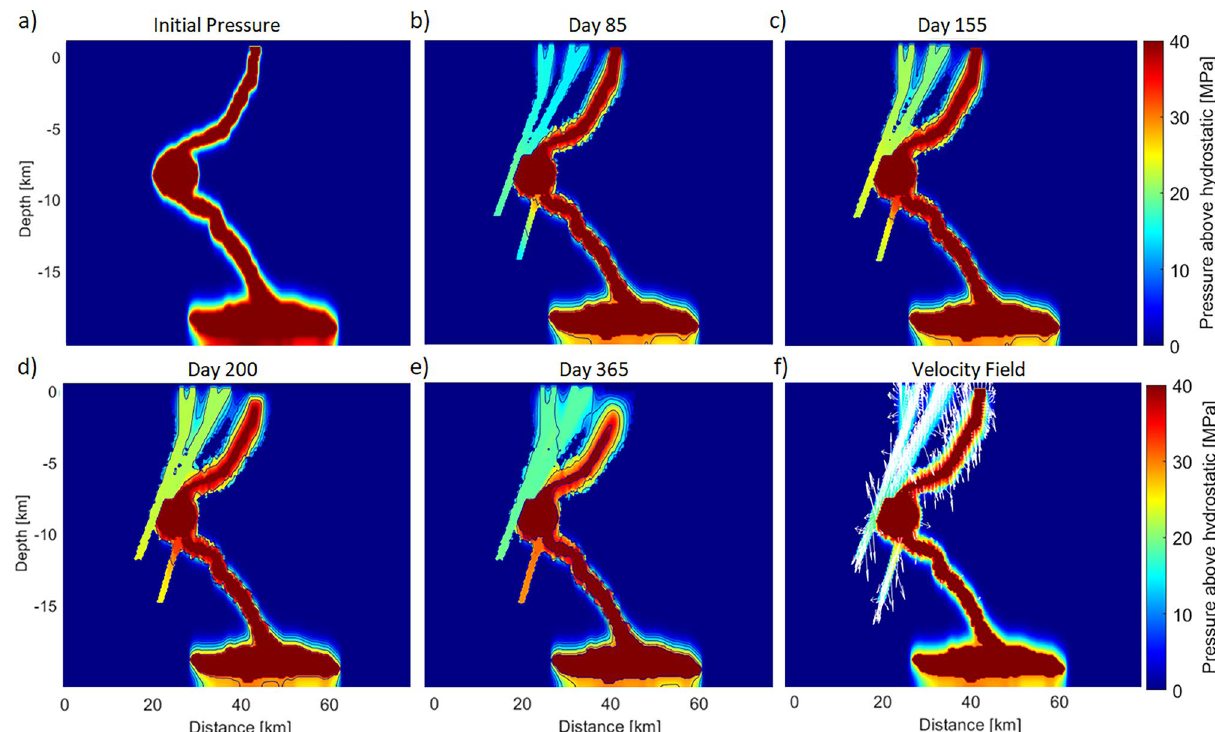
Figure 3. Calculated fluid pressure. ( a ) The steady state pressure distribution at the beginning of the simulation. ( b,c ) The fluid pressure is increasing within the faults toward the surface. ( d,e ) After the massive volcanic eruption on October 8, 2016, the fluid pressure decreases. The contour lines clearly illustrate these changes along the model. ( f ) The velocity field reflects the stream of the fluid pressure through the porous medium and show both the pressure propagation into the lower part of the chamber along the faults and into the upward oriented faults, allowing the rising of magmatic fluid towards the